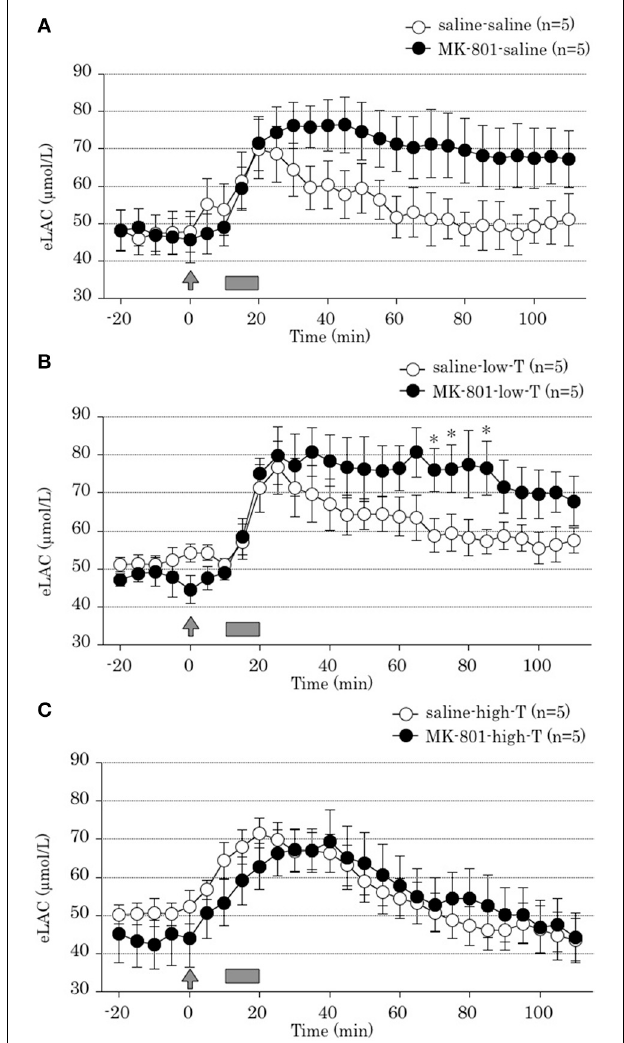
FIGURE 3 | Effect of tandospirone on foot-shock stress-induced increment of the extracellular lactate concentrations (eLAC) in the medial prefrontal cortex in rats treated with (A) saline (saline-saline group, n = 5; MK-801-saline group, n = 5), (B) tandospirone 0.05mg/kg (saline-low-T group, n = 5; MK-801-low-T group, n-5) and (C) 5.0mg/kg tandospirone (saline-high-T group, n = 5; MK-801-high-T group, n = 5). Rats were simultaneously treated with saline (open circle) or MK-801 (closed circle), respectively. Lactate levels in the dialysates are expressed as μ mol/l calculated by a standard solution of 100 μ mol/l lactate. Data are mean ± s.e.m. The arrow indicates the timing of the last injection. Foot-shock is indicated by solid bars. Asterisk showed p < 0 . 05 vs. saline group in each time